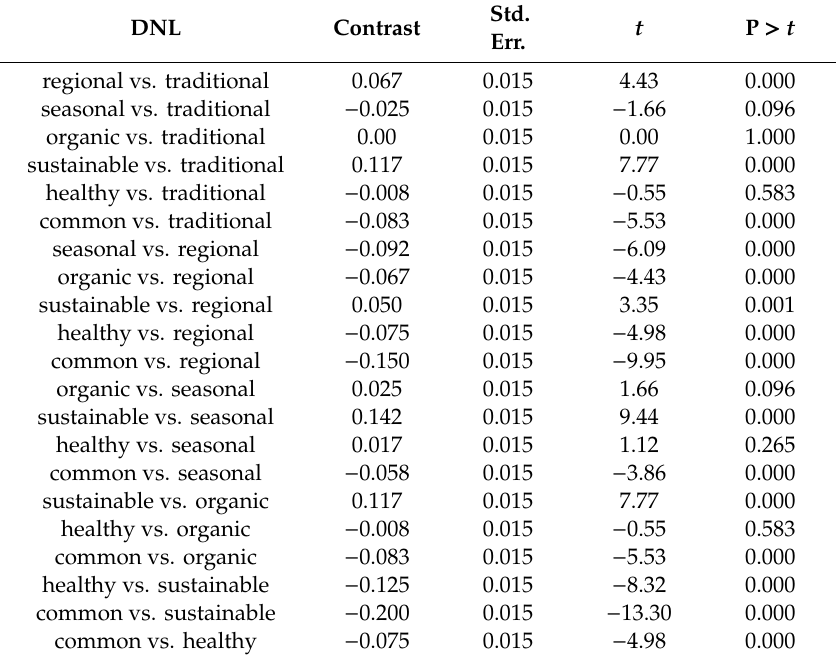
sustainable vs. organic common vs. organic healthy vs. sustainable − 0.125 common vs. sustainable − 0.200 0.015 0.000 common vs. healthy − 0.075 0.015